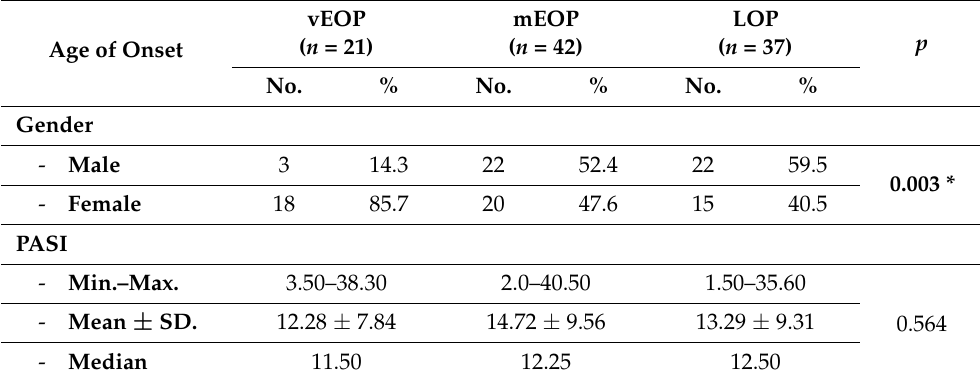
Table 3. Relation between age of onset with gender and PASI in patient group ( n = 100). vEOP ( n = 21) Age of Onset